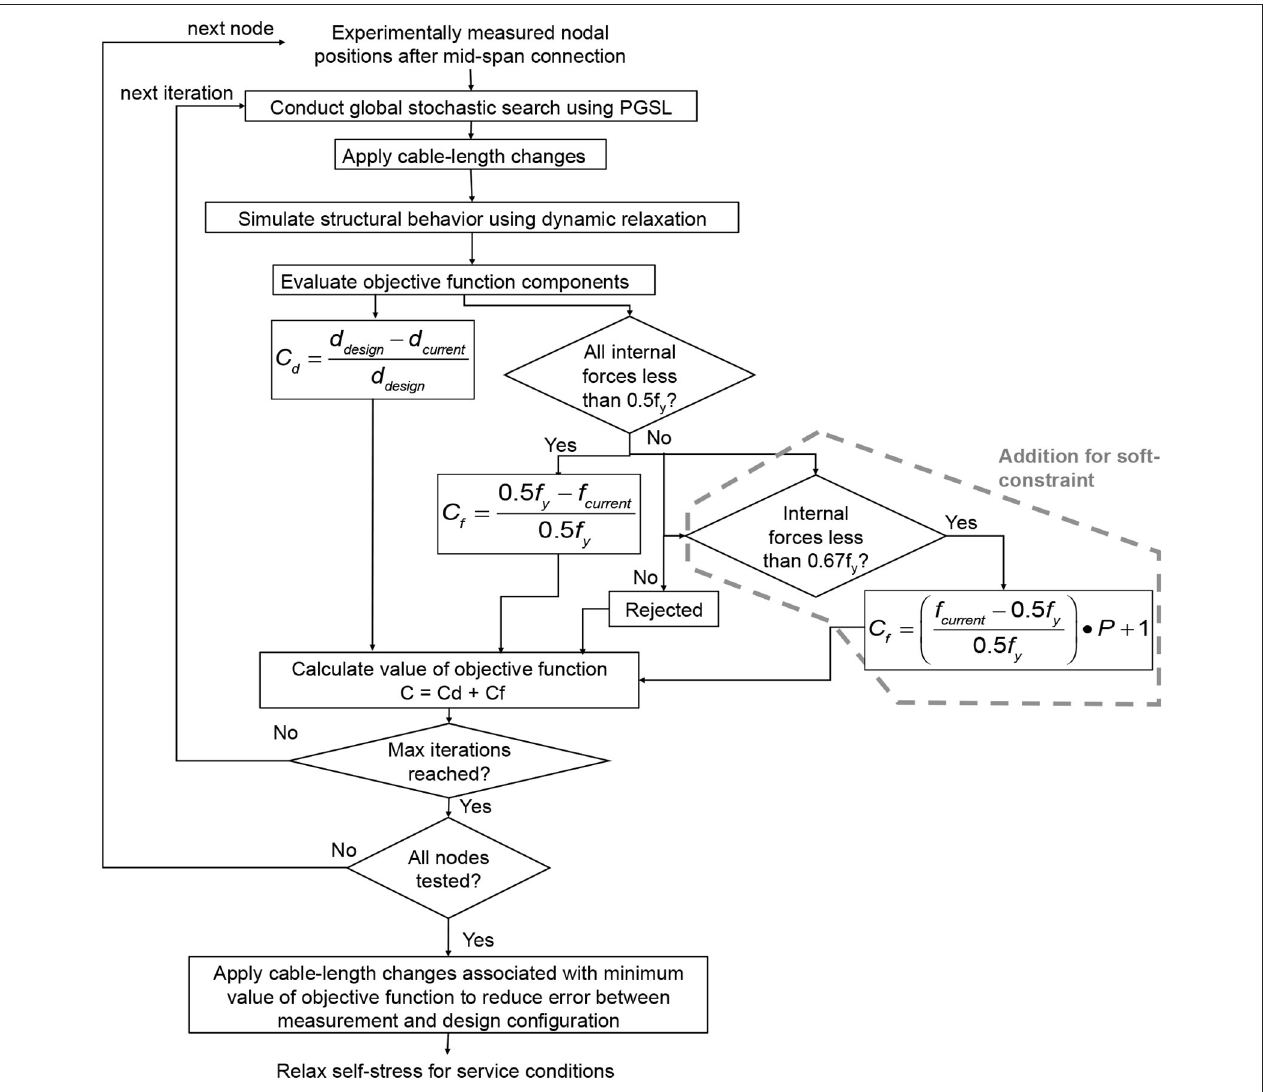
FIGURE 8 | Procedure for multi-criteria objective function within the stochastic search algorithm, PGSL. Cable-length changes govern the objective function